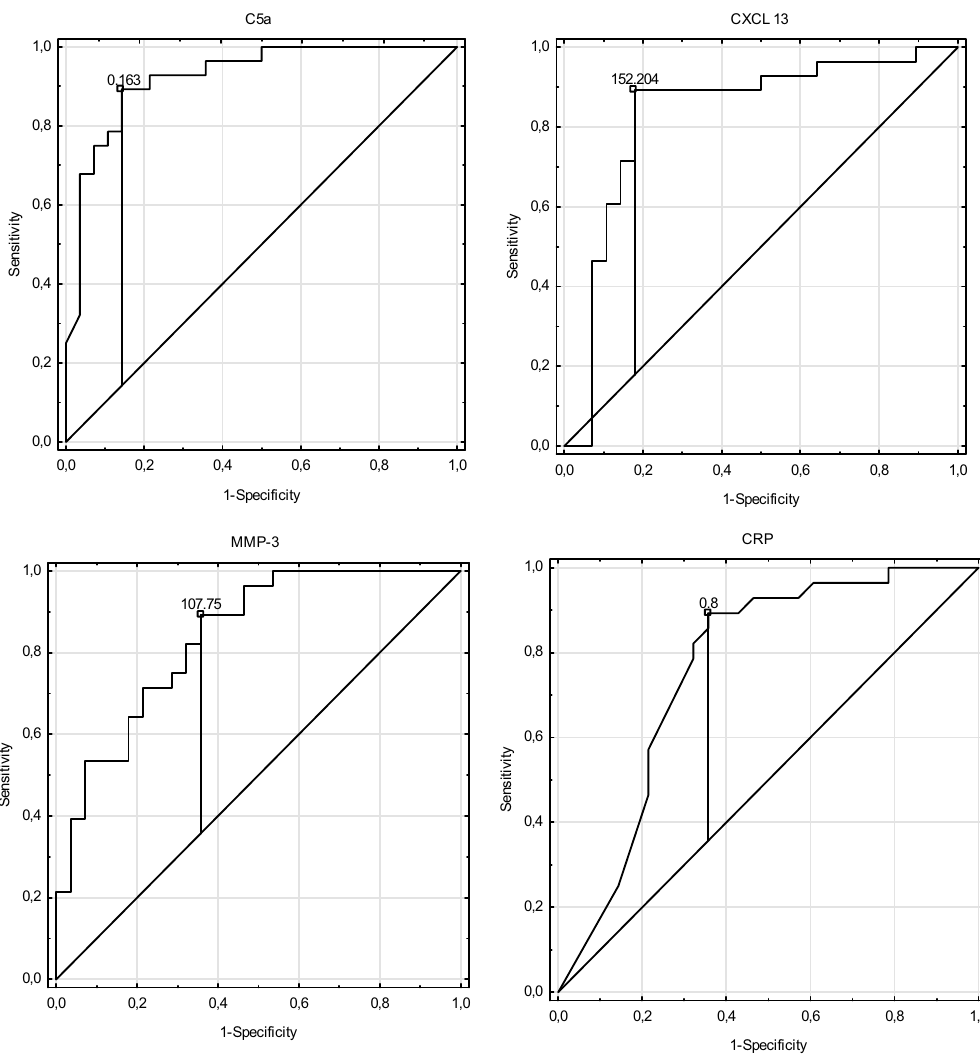
Figure 1. Receiver operating characteristic curve for C5a, CXCL-13, MMP-3 and CRP showing the ability of markers to distinguish active vasculitis (Active Group) from the control group with cut-off points.